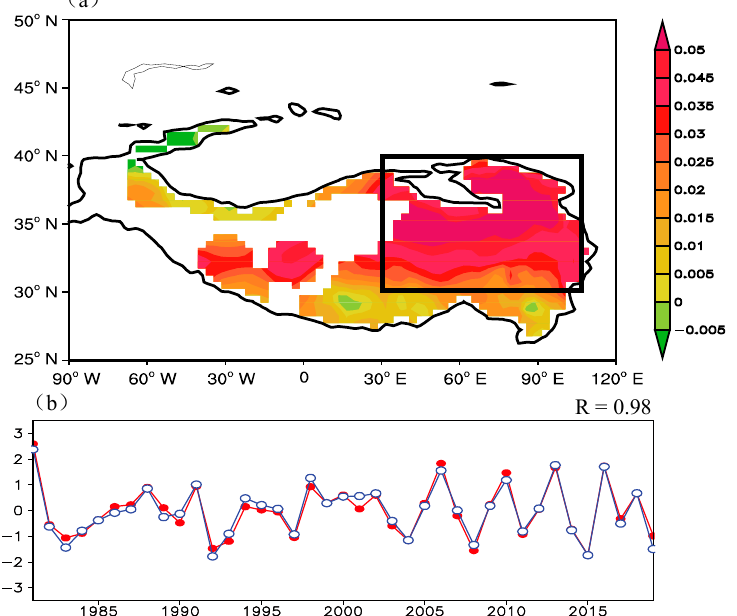
Figure 1. ( a ) The first mode (EOF1) of summer surface air temperature (SAT) anomalies over the Tibetan Plateau (TP) during the period 1981–2019, in which the linear trends in the SATs were removed. The black box denotes the eastern TP region (30° N–40° N, 90° E–103° E). ( b ) Standardized time series of the summer TP SAT (red line) and PC1 (blue line) indices.